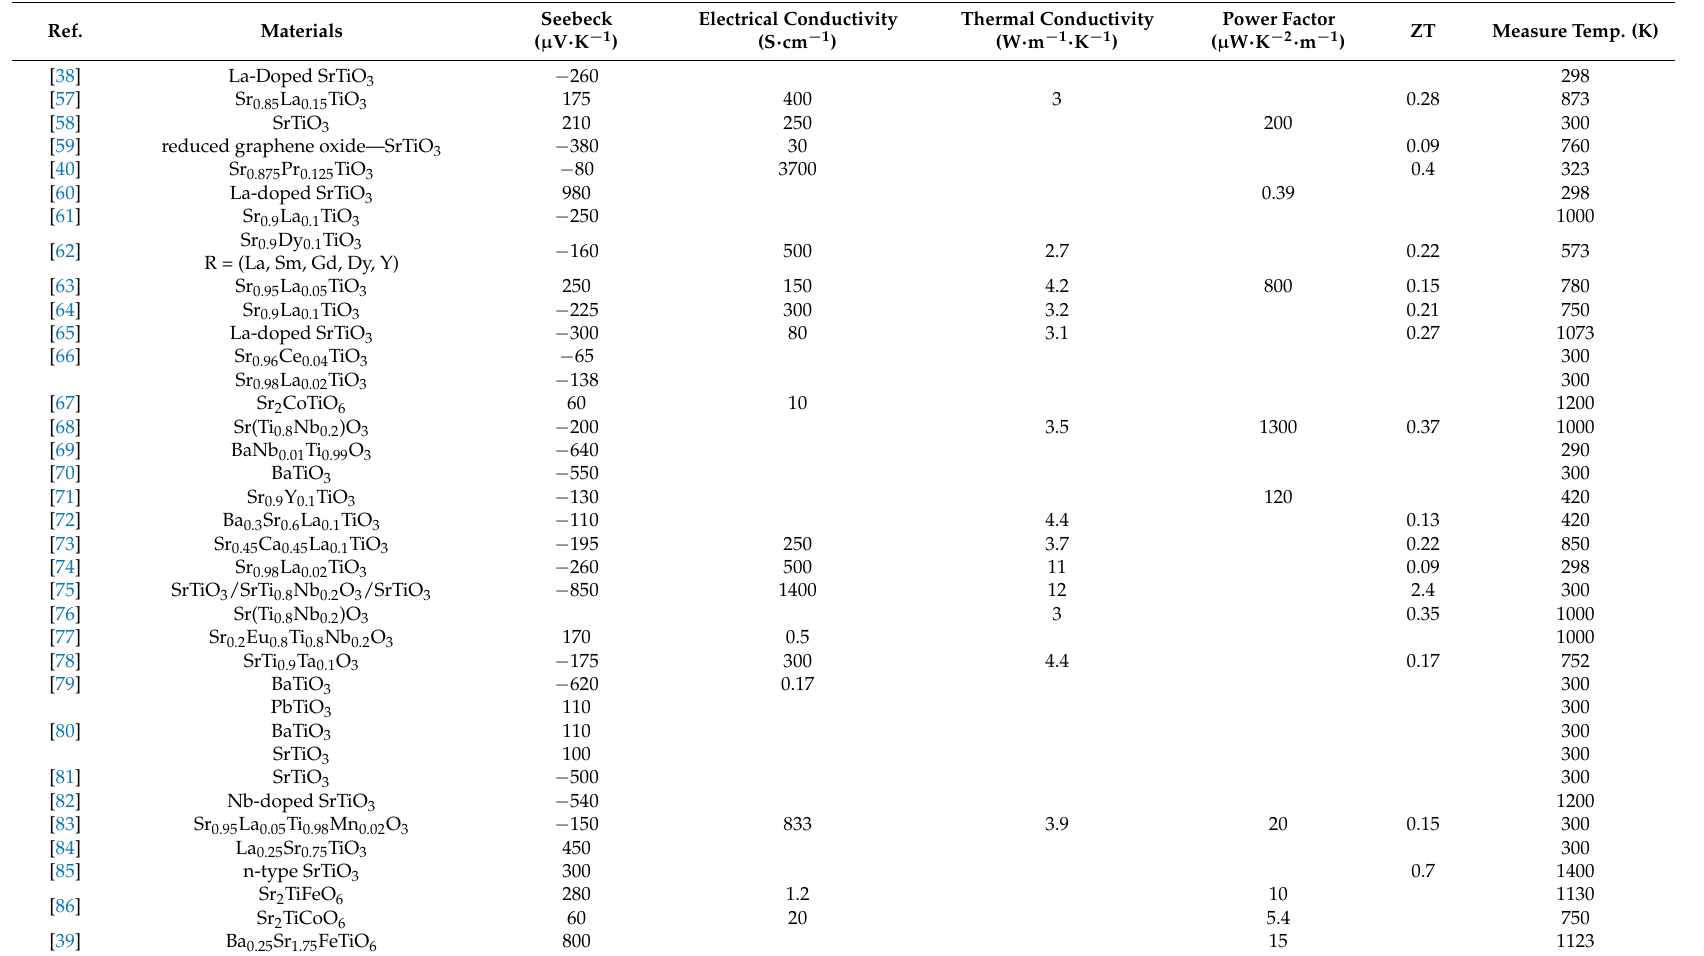
Table 1. Literature data about TE properties of perovskite